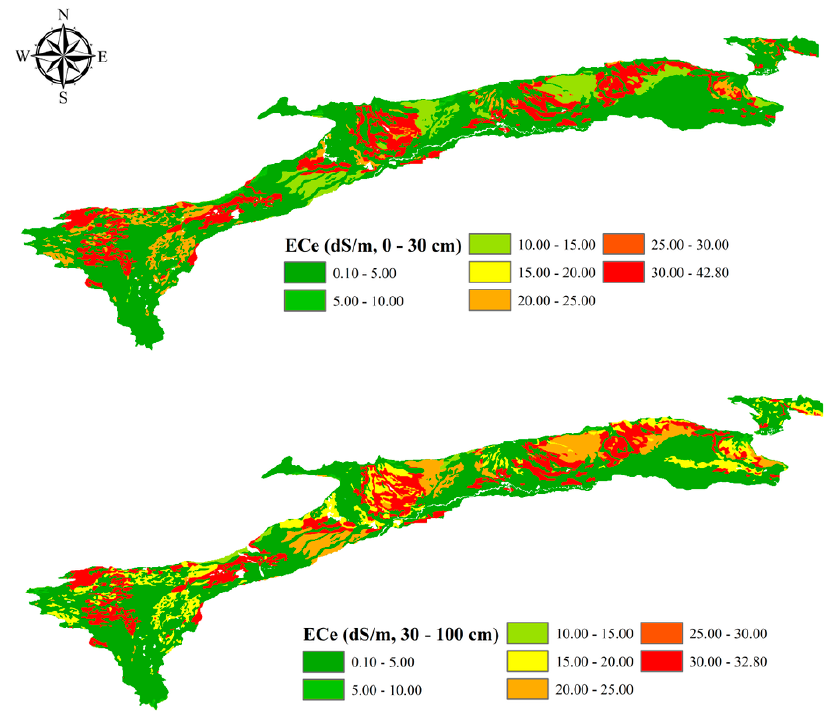
Figure 8. Soil salinity map of the study area derived from the harmonized world soil database (V1.2), generated between the 1970s and 1980s.